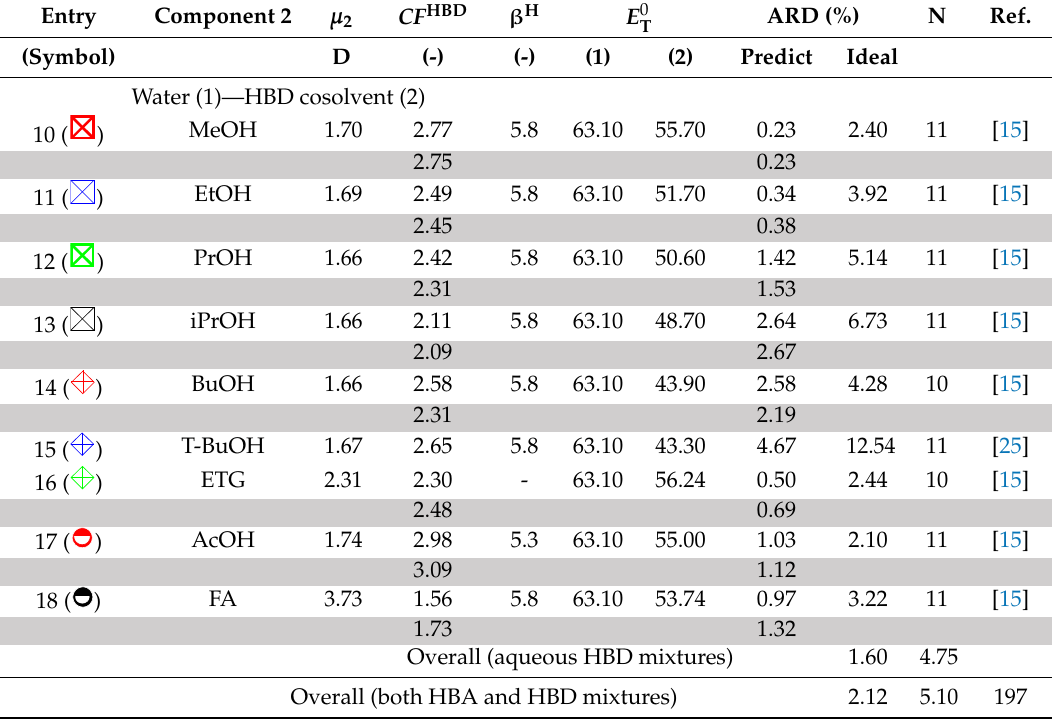
The µ 2 values for all solvents are taken from handbook [29], except for GVL [32]. The overall average relative deviation (ARD) values are calculated without considering the values in the gray-shaded rows. Solvent abbreviations for HBD cosolvent are given in Table 1. Solvent abbreviations for HBA cosolvent: ACN = acetonitrile; THF = tetrahydrofuran; GBL = gamma butyrolactone; GVL = gamma valerolactone; PYR = 2-pyrrolidinone; NMP = N-methyl-2-pyrrolidone; DMF = dimethylformamide and DMSO = dimethyl sulfoxide.